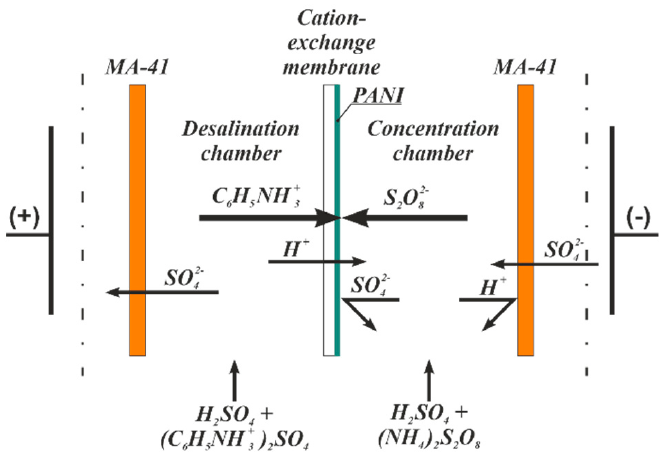
Figure 1. Synthesis of polyaniline (PANI) in the surface layer of the membrane in an elementary electrodialysis cell.